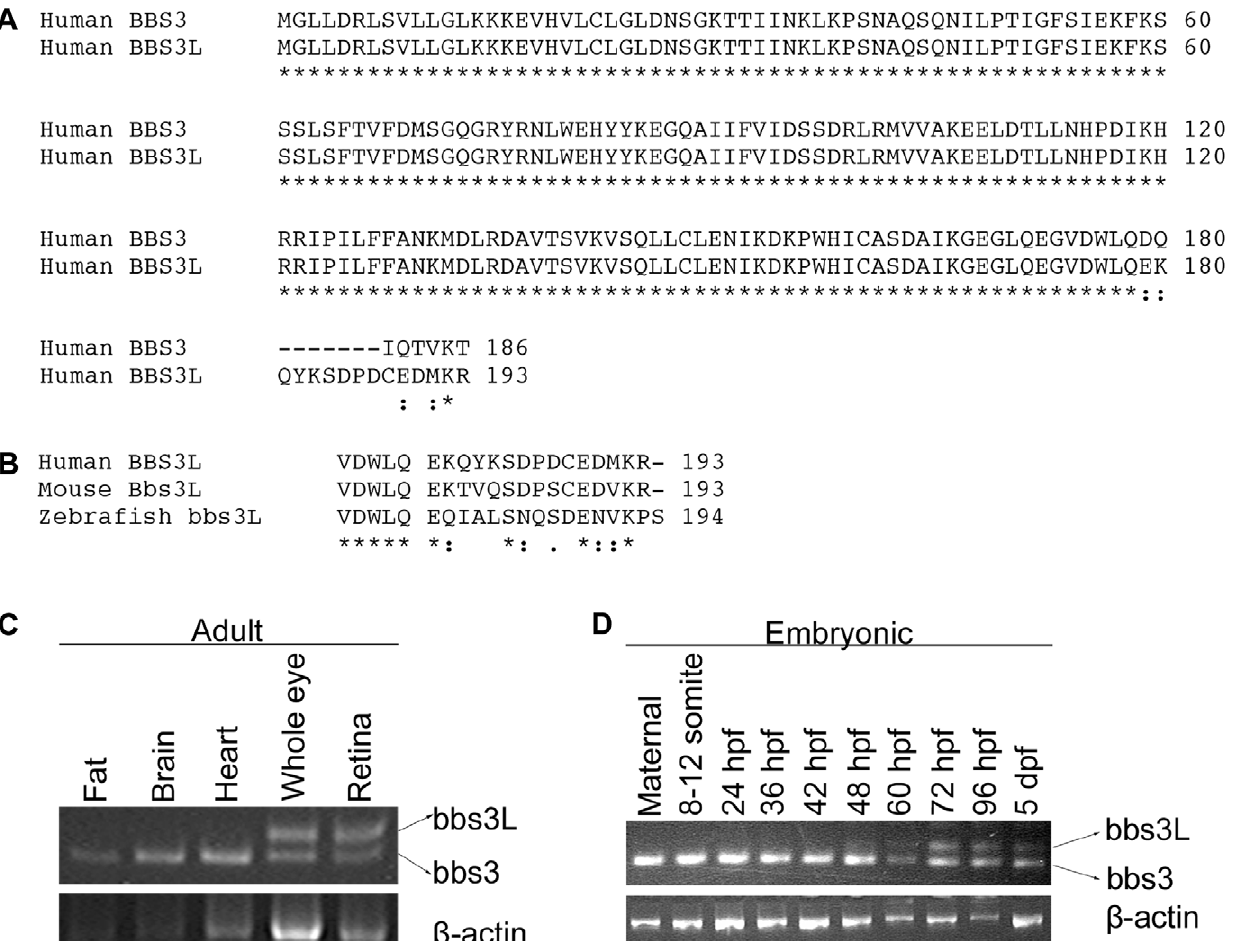
MO-induced defect (Table S1). Myc-tagged BBS3 and BBS3L RNA injection and Western blot analysis confirmed expression of